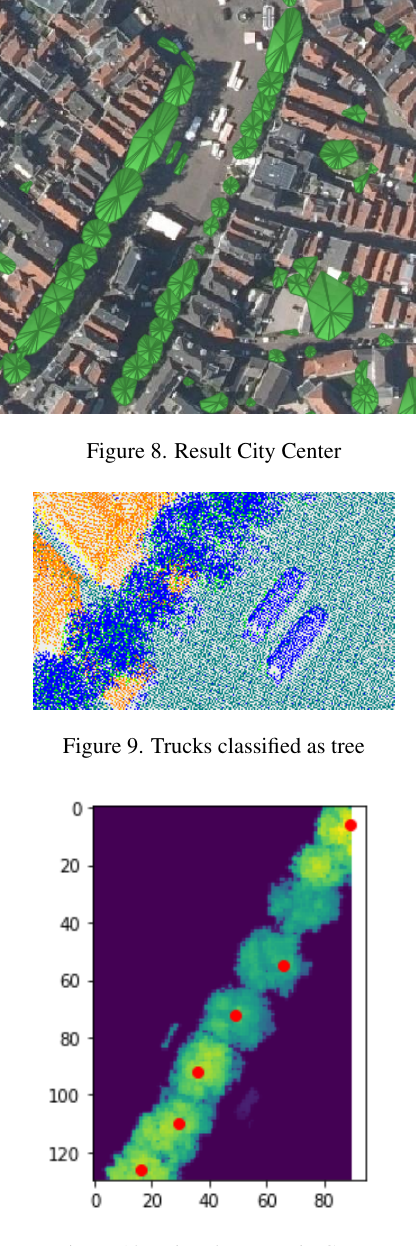
Figure 10. Missed tree top in